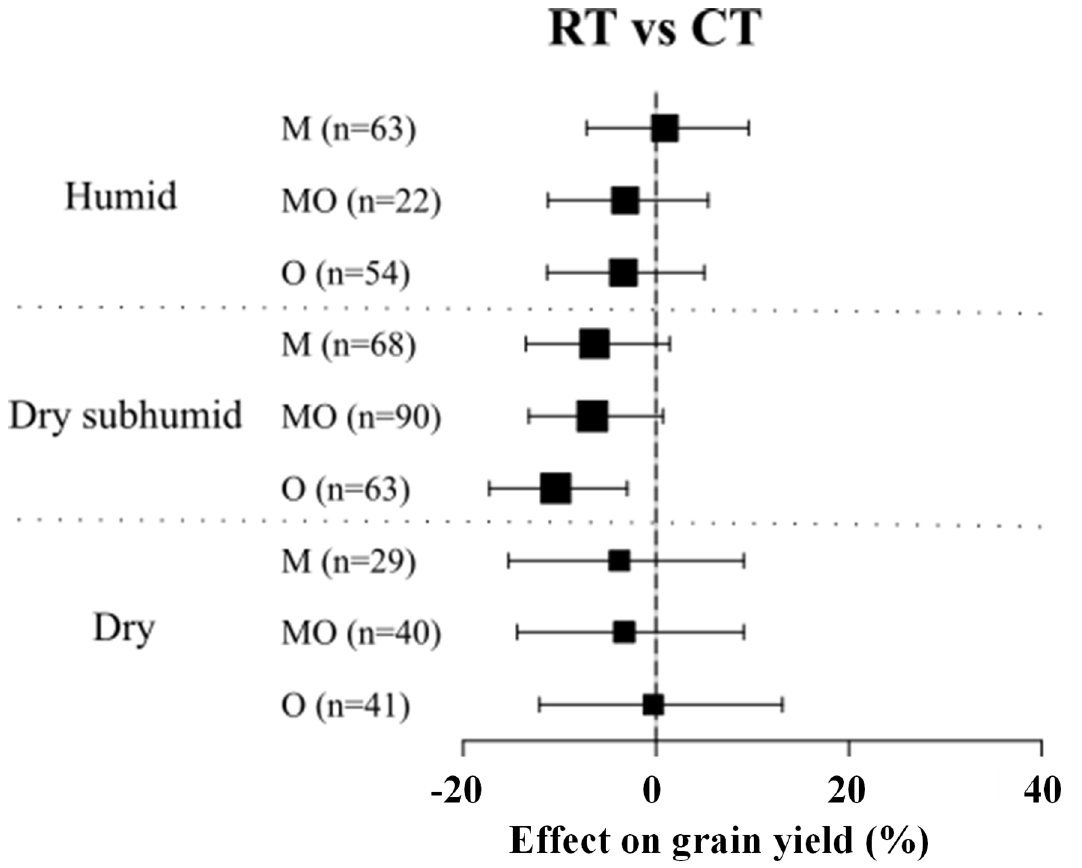
Figure 2. The response of reduced tillage vs. the conventional tillage practices (RT vs. CT), under different nutrient sources; inorganic (M), organic (O), and inorganic + organic (MO), under different climate conditions, expressed as the average effect on grain yield (%). “n” refers to the number of observations for each subgroup. The vertical line represents the null hypothesis [ln (RR) = 0]. The squares are the point estimate of effect size. The horizontal lines are the associated 95% confidence interval for the population parameter.